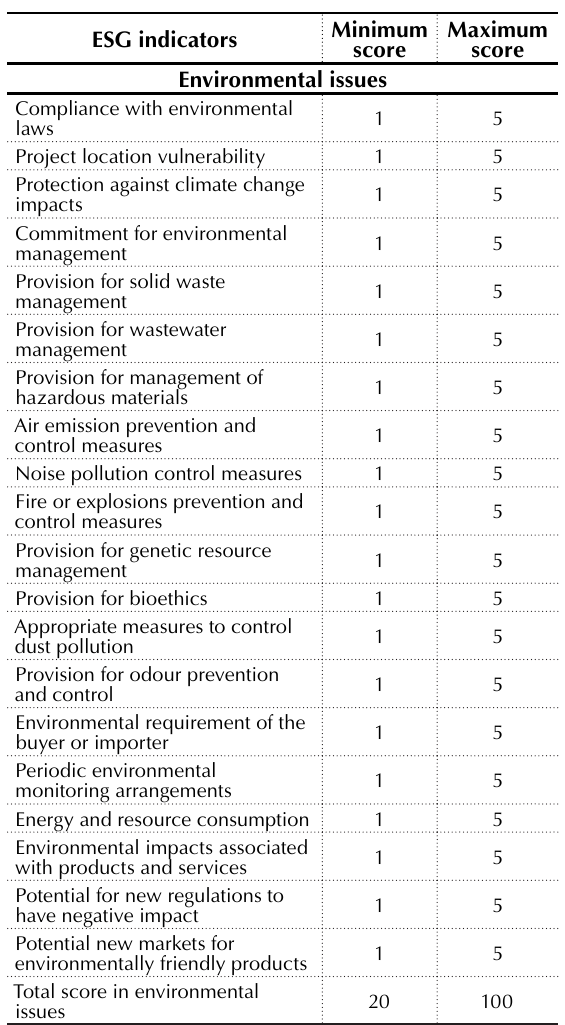
Table 1. Factors considered in calculating